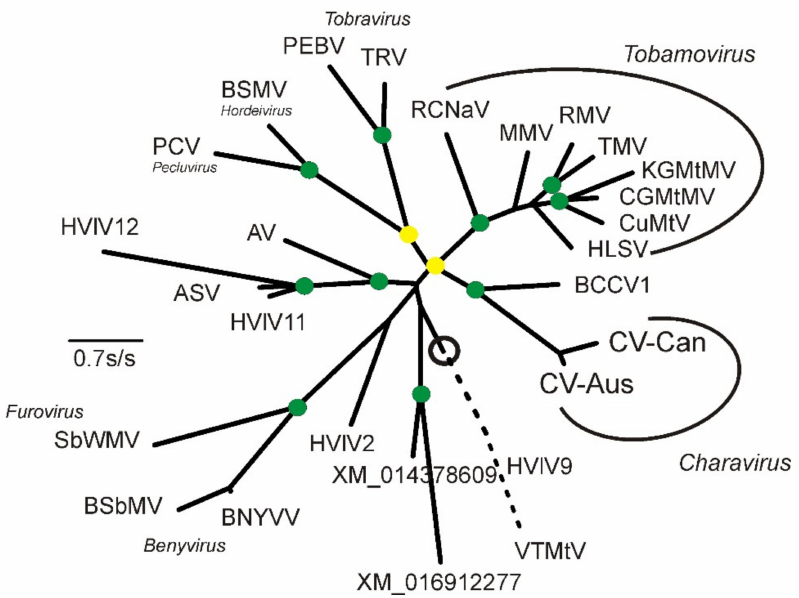
Figure 3. Maximum-likelihood phylogeny of the amino acid sequences of the CPs, and CP-like proteins, of the charaviruses and relatives. These include: AV, Abisko virus (NC_035470); ASV, Adelphocoris suturalis virus (NC_032728); BCCV1, Beihai Charybdis crab virus 1 (NC_032449); BNYVV, Beet necrotic yellow vein virus (NC_003515); BSbMV, Beet soil-borne mosaic virus, (NC_003503); BSMV. Barley stripe mosaic virus (NC_003481); CGMtMV, Cucumber green mottle mosaic virus (NC_001801); CuMtV, Cucumber mottle virus (NC_008614); CV-Aus, Charavirus australis (JF824737); CV-Can, Charavirus canadensis (MK521928); HLSV, Hibiscus latent Singapore virus (NC_008310); HVlV2; Hubei virga-like virus 2 (NC_033158); HVlV9, Hubei virga-like virus 9 (NC_032765); HVlV11, Hubei virga-like virus 11 (NC_033082); HVlV12, Hubei virga-like virus 12 (NC_033269); KGMtMV, Kyuri green mottle mosaic virus (NC_003610); MMV, Maracuja mosaic virus (NC_008716); PCV, Peanut clump virus (NC_003668); PEBV, Pea early browning virus (NC_001368); RCNaV, Rattail cactus necrosis-associated virus (NC_016442); RMV, Ribgrass mosaic virus (NC_002792); SbWMV, Soil-borne wheat mosaic virus (NC_002042); TMV, Tobacco mosaic virus (NC_001367); TRV, Tobacco rattle virus (NC_003811); VTMtV, Velvet tobacco mottle virus (NC_014509); XM_014378609, a gene from Apis mellifera ; XM_016912277, a gene from Trichogramma pretiosum . The circle marks the midpoint of the phylogeny, and the broken line is the branch to the outgroup of HVlV9 and VTMtV drawn only at 50% of its true length. The green discs mark nodes with >0.9 SH support and the yellow discs those with >0.8 < 0.9 SH